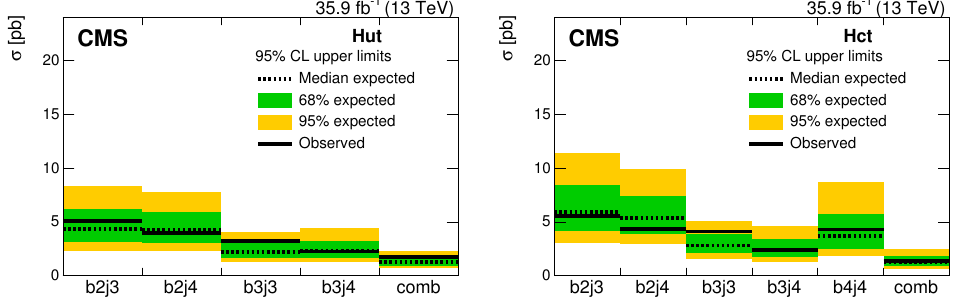
Figure 5 . Excluded signal cross section at 95% CL per event category for Hut (left) and Hct (right).